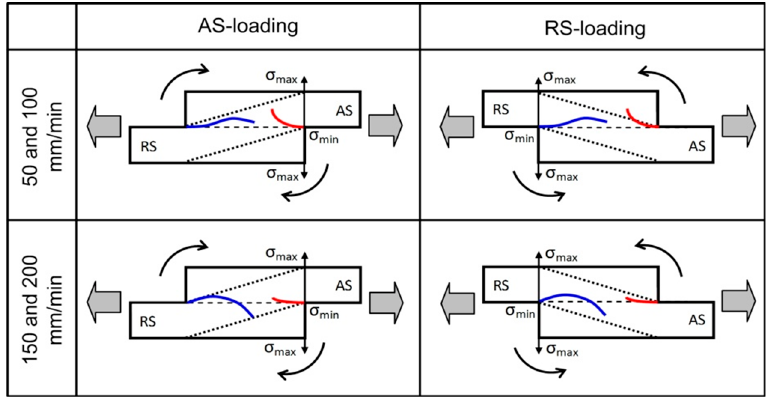
Figure 11. Schematic views of tensile behavior of lap joints under different loading configurations.